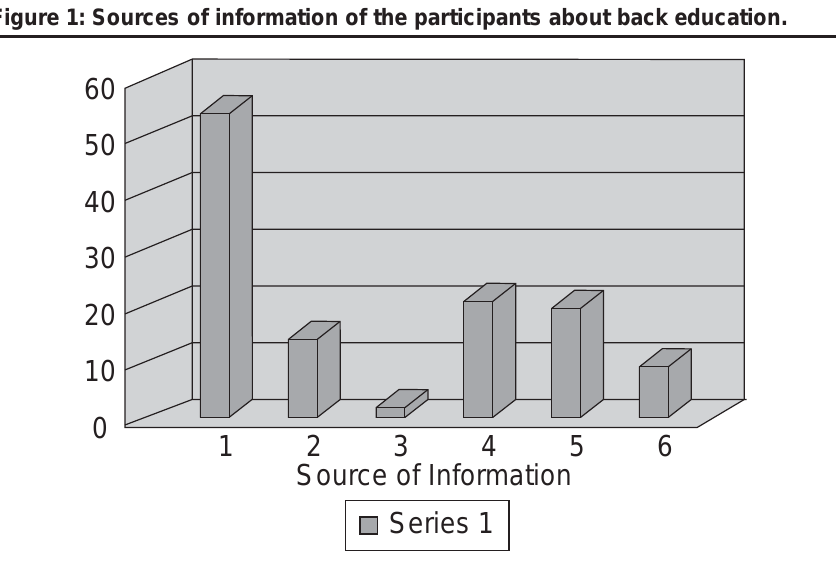
KEY: 1 - No formal education, 2 - Print media, 3 - Communication